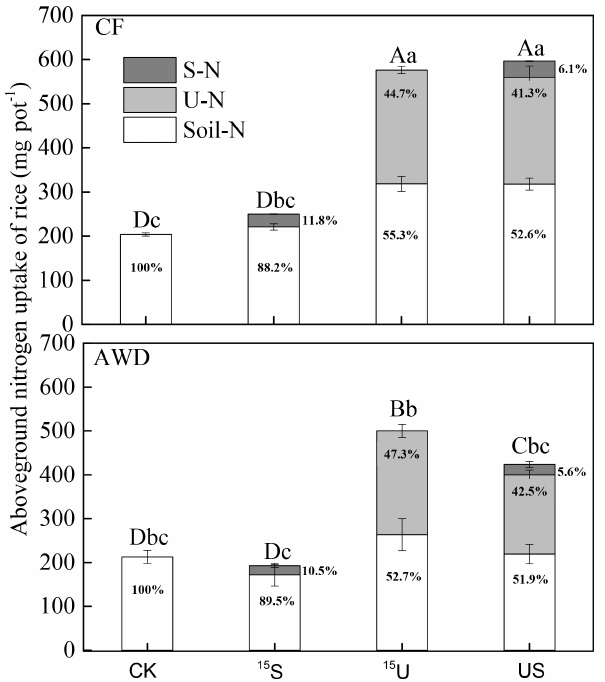
Figure 4. The source of nitrogen in the aboveground biomass of rice at the maturity stage ( n = 3). CF: continuous flooding irriga- tion, AWD: mild alternate wetting and drying irrigation, Soil-N: soil-derived nitrogen, U-N: urea-derived nitrogen, S-N: Rice straw- derived nitrogen. Different capital letters indicate significant differ- ences in total nitrogen uptake of rice above ground ( P < 0 . 05), and different lowercase letters indicate significant differences in soil- nitrogen supply ( P < 0 .